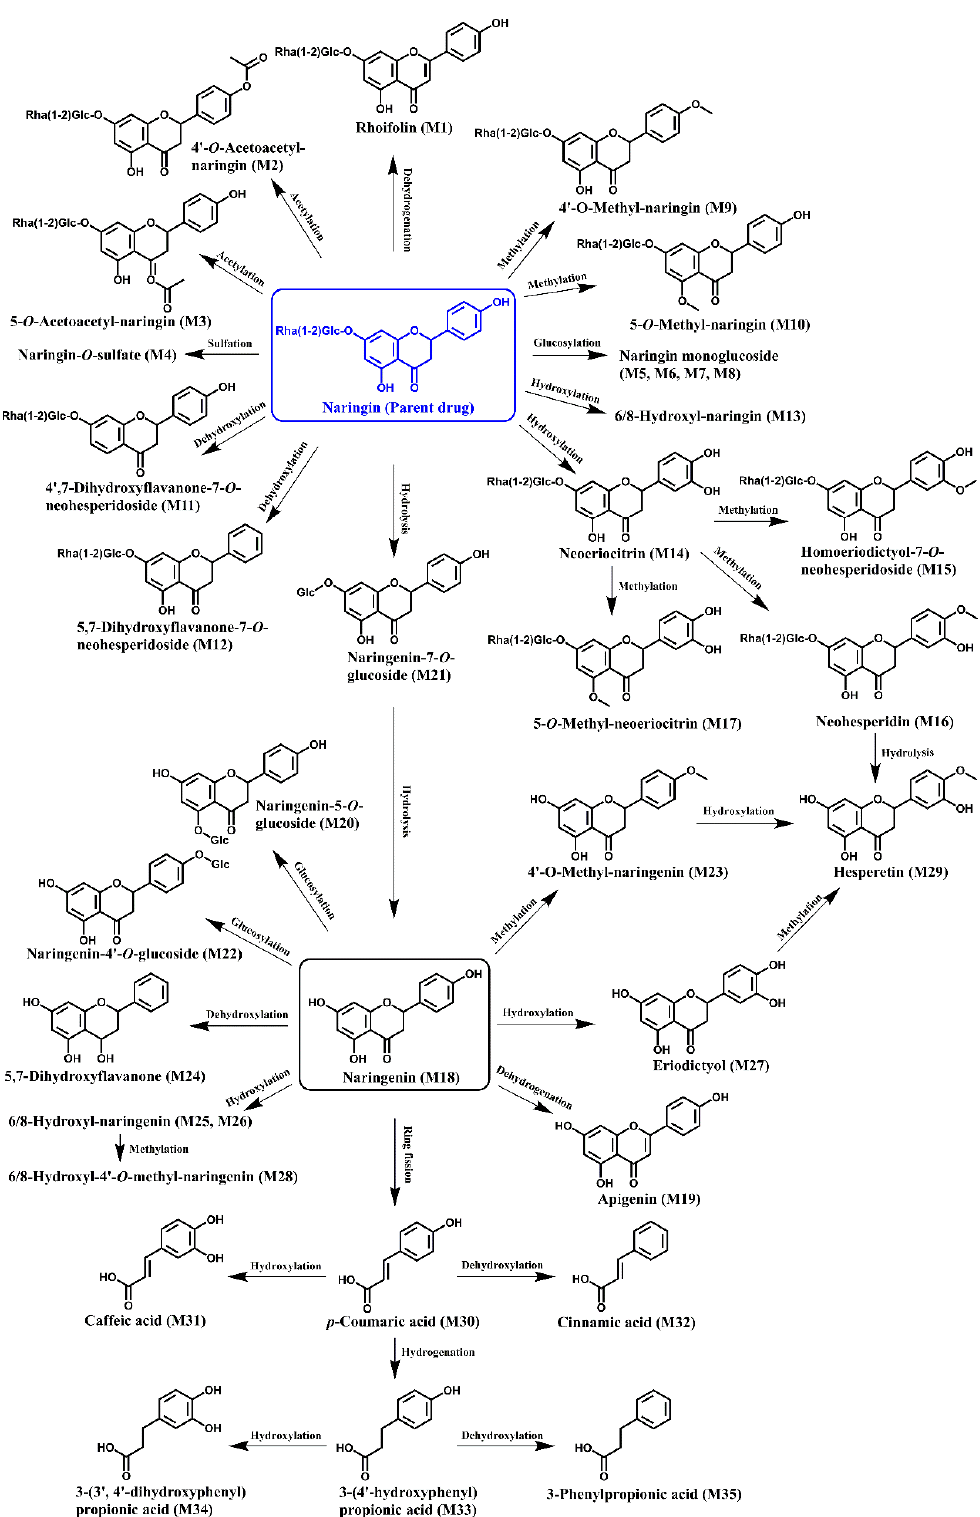
Figure 1. Potential pathways for the metabolism of naringin by rat gut microbiota. The numbers of metabolites in brackets corresponds to those in Table 1.